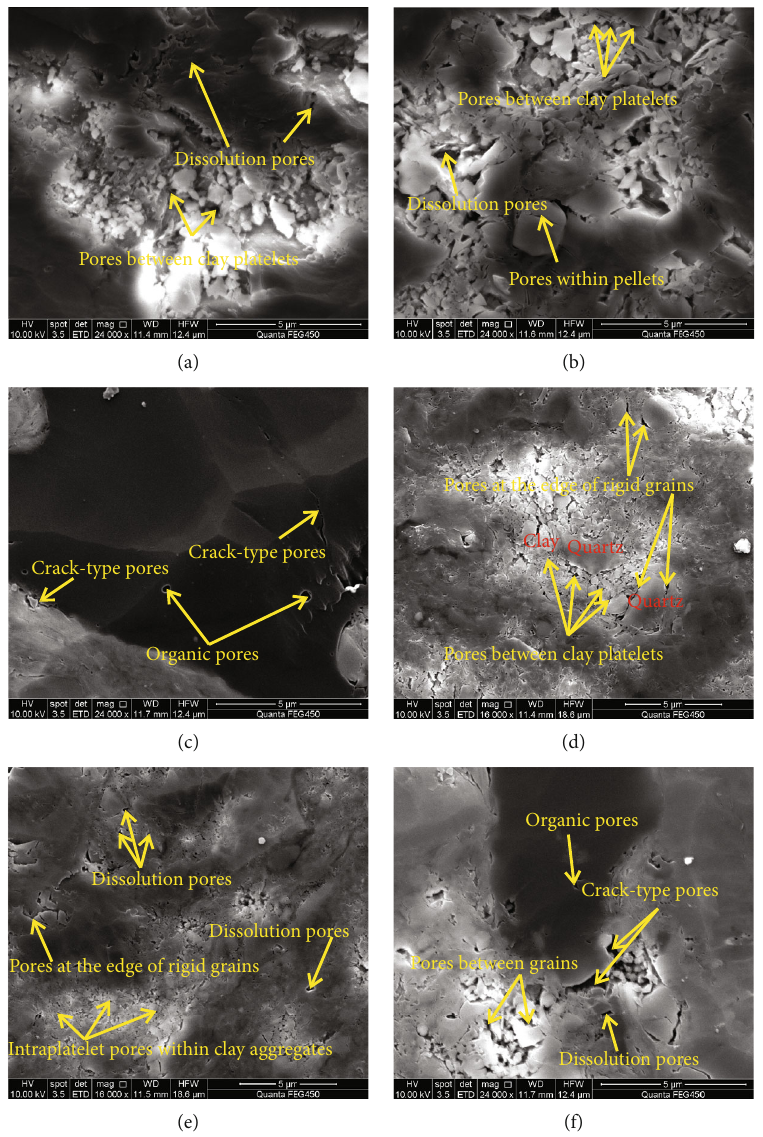
Figure 4: Scanning electron microscopy images of the K